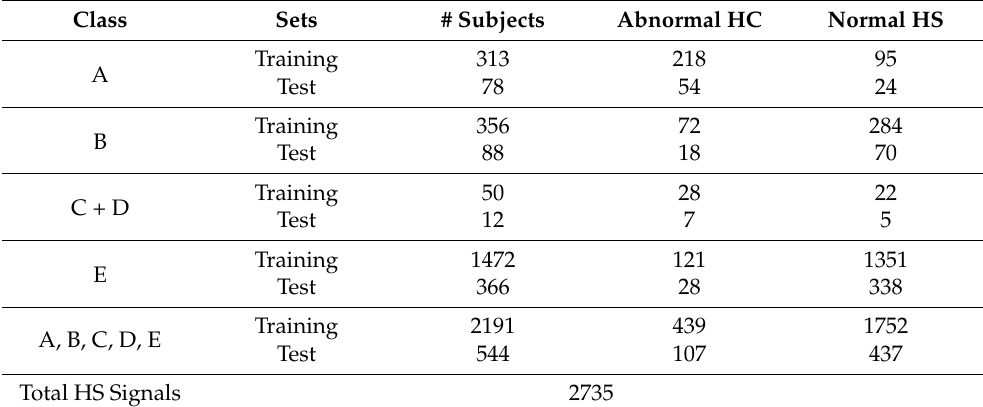
Table 1. Dataset